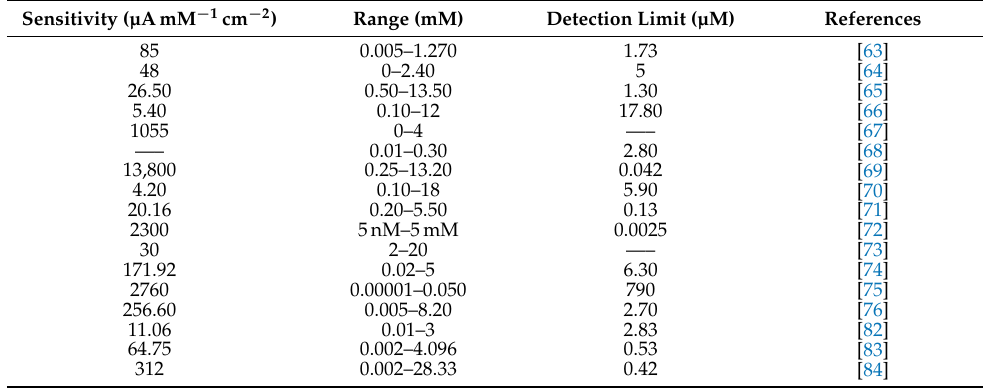
Table 1. Comparison of different graphene-based electrodes for glucose